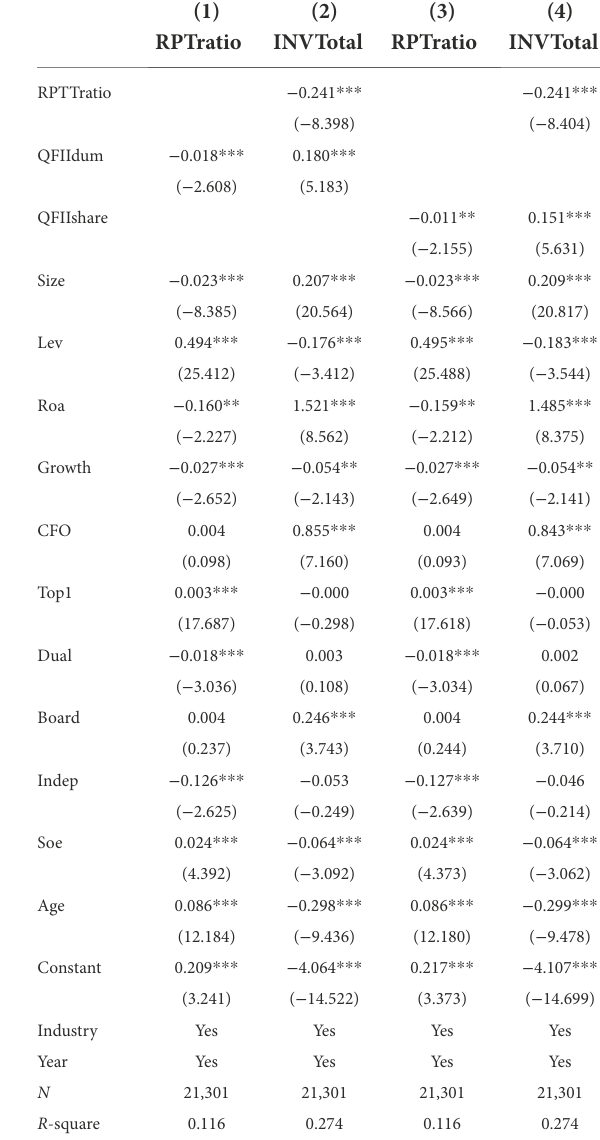
TABLE 5A The impact of QFII on the number of innovations: A mechanism test based on the behavior of the firm’s